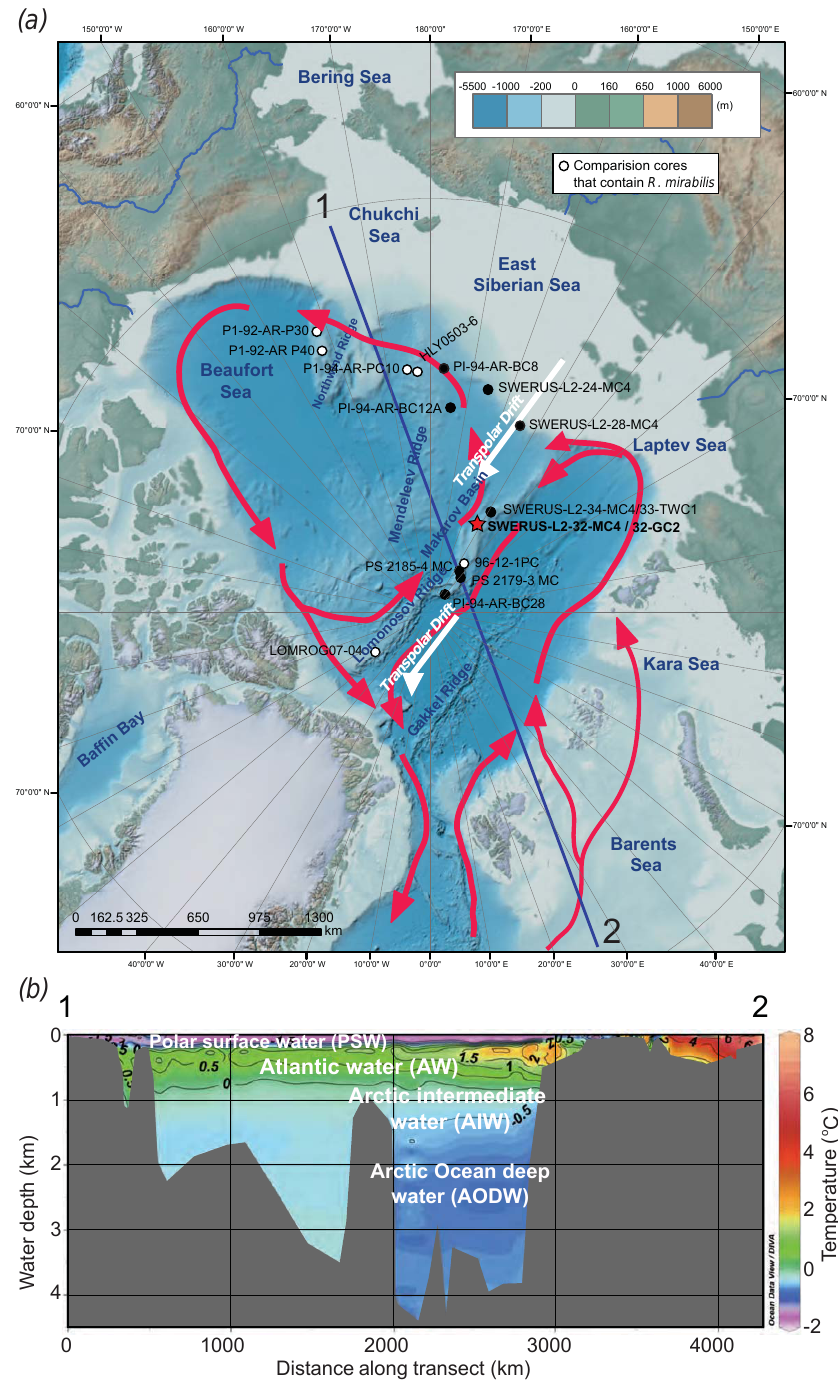
Figure 1. (a) International Bathymetric Chart of the Arctic Ocean showing the location of this study’s primary sediment cores on the Lomonosov Ridge (red star: 32-GC2 and 32-MC4), as well as other core sites discussed in this paper (black and white circles). (See Table 1 for supplemental core data.) White circles designate cores that contain Rabilimis mirabilis events. Red arrows show generalized circulation patterns of warm Atlantic Water in the Arctic Ocean. White arrows indicate the surface flow of the Transpolar Drift, which moves sea ice from the Siberian coast of Russia across the Arctic Basin, exiting into the North Atlantic off the east coast of Greenland. Transect line through the map from “1” in the Chukchi Sea to “2” in the Barents Sea shows direction of temperature profile in (b) . (b) Cross section of modern Arctic Ocean temperature profile from showing major water masses. PSW: Polar Surface Water; AL: Atlantic layer; AIW: Arctic Intermediate Water; AODW: Arctic Ocean Deep Water. Ocean Data View source: Schlitzer, 2012. Ocean Data View: